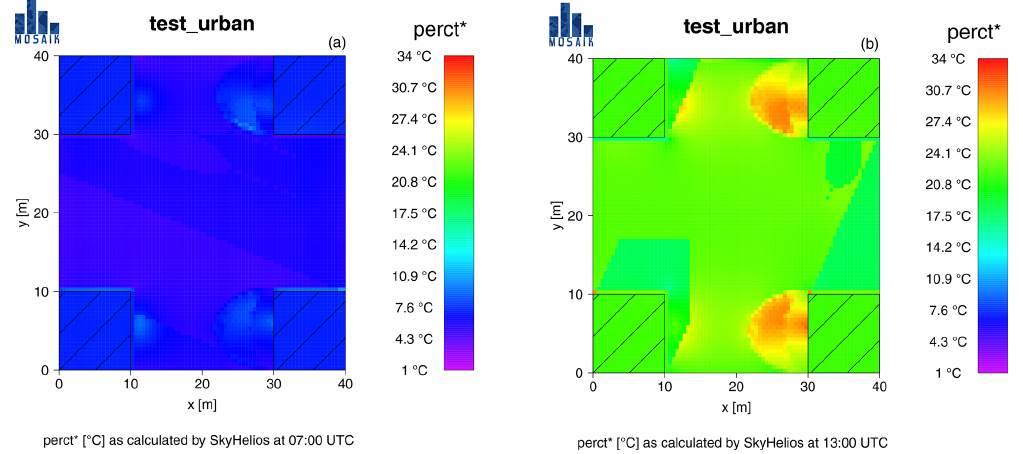
Figure 7. PT (perct ∗ in PALM) for the test case “test_urban” at 07:00UTC (a) and 13:00UTC (b) on 6 March as calculated by the SkyHelios